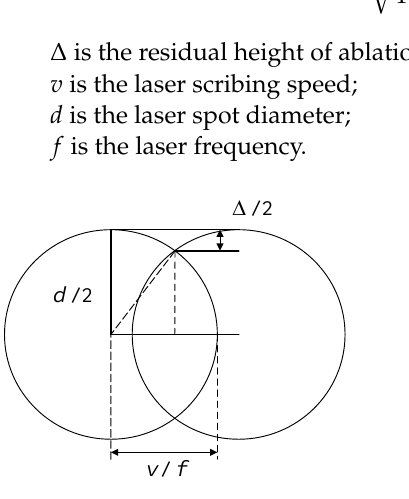
Figure 15. Overlap rate and residual height of ablation width.